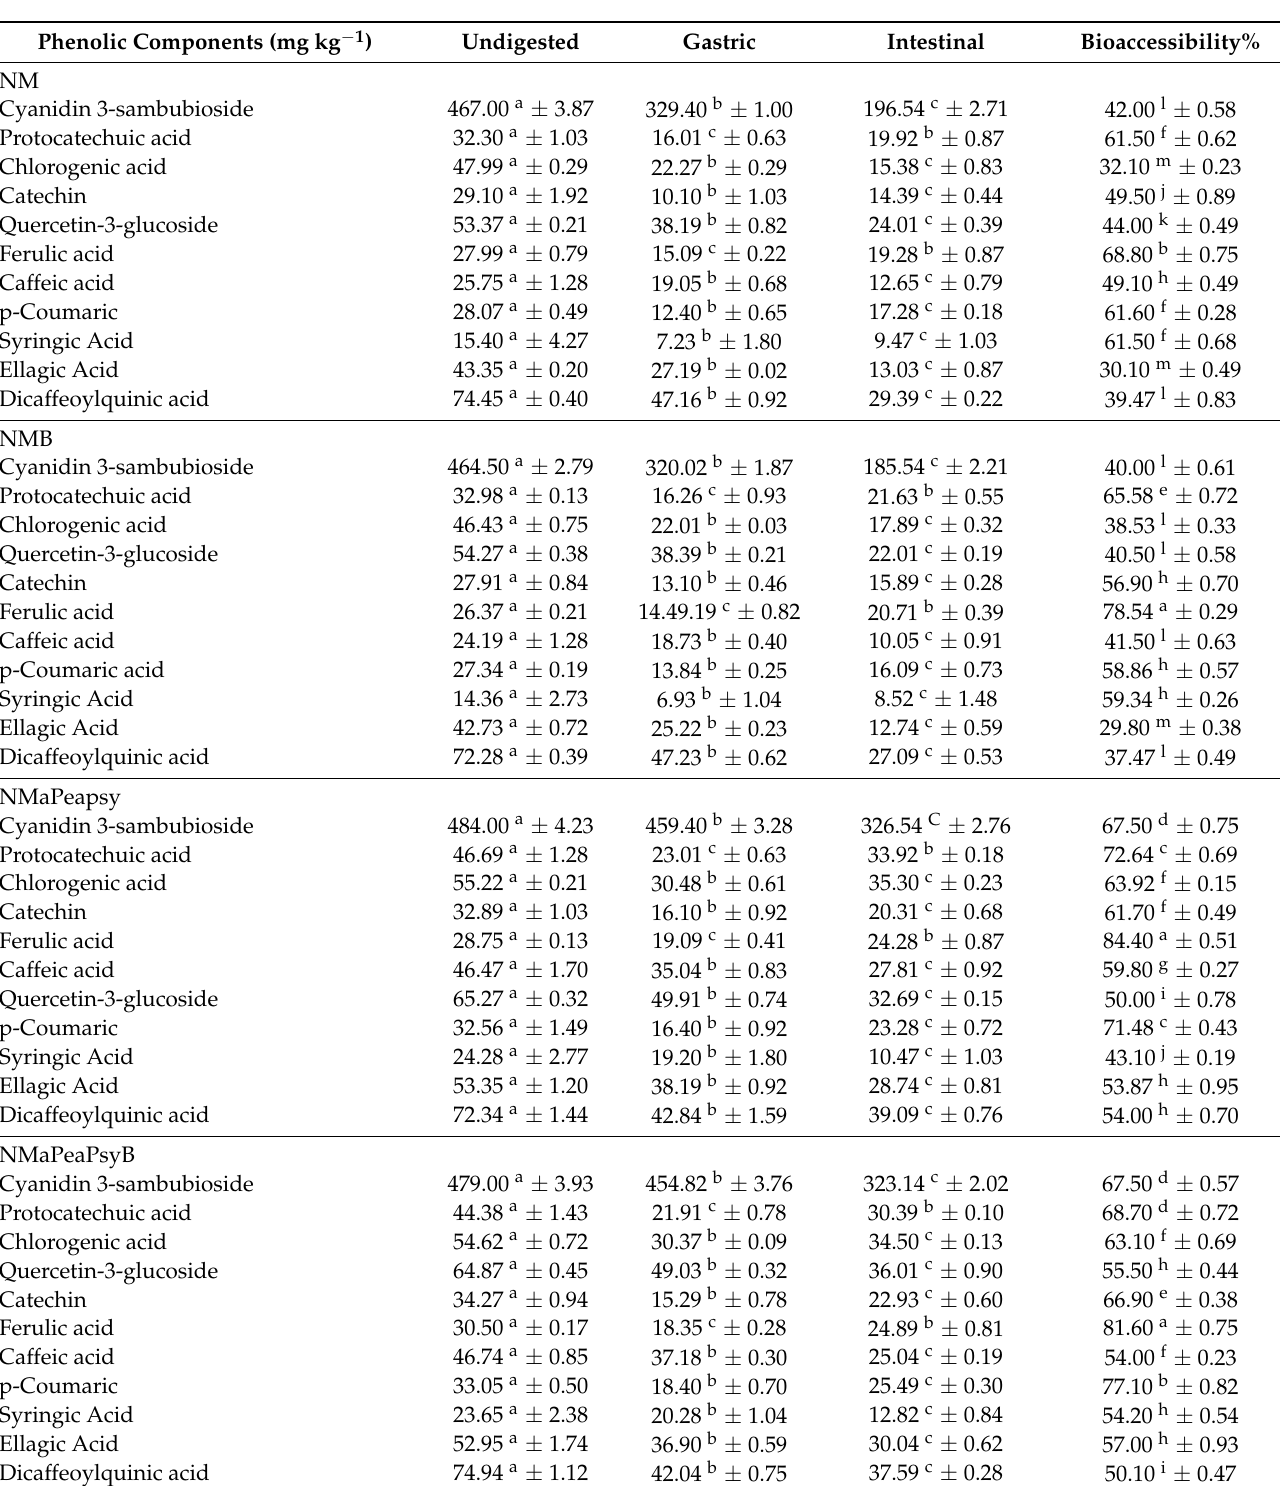
Table 4. Changes in phenolic components in Natal plum ( Carissa macrocarpa ) juice samples during gastrointestinal digestion for selected samples on a dry weight